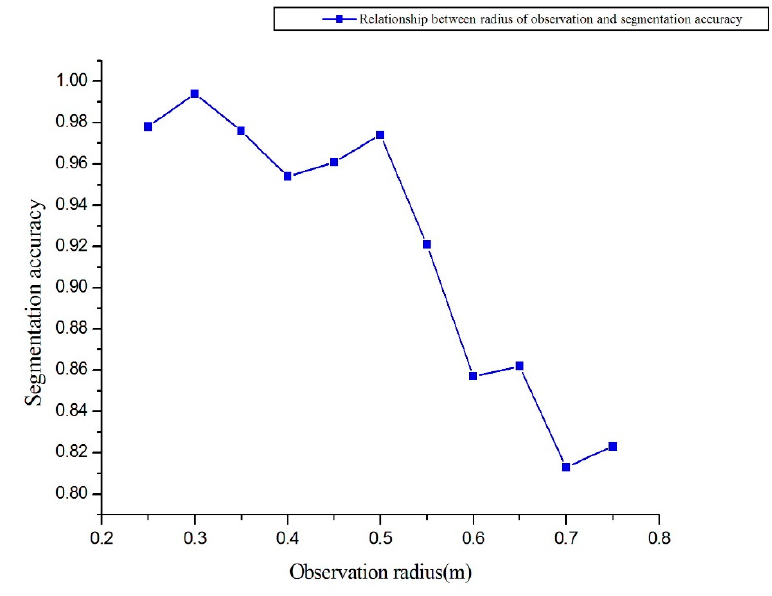
Figure 11. Segmentation accuracy as a function of observation radius.